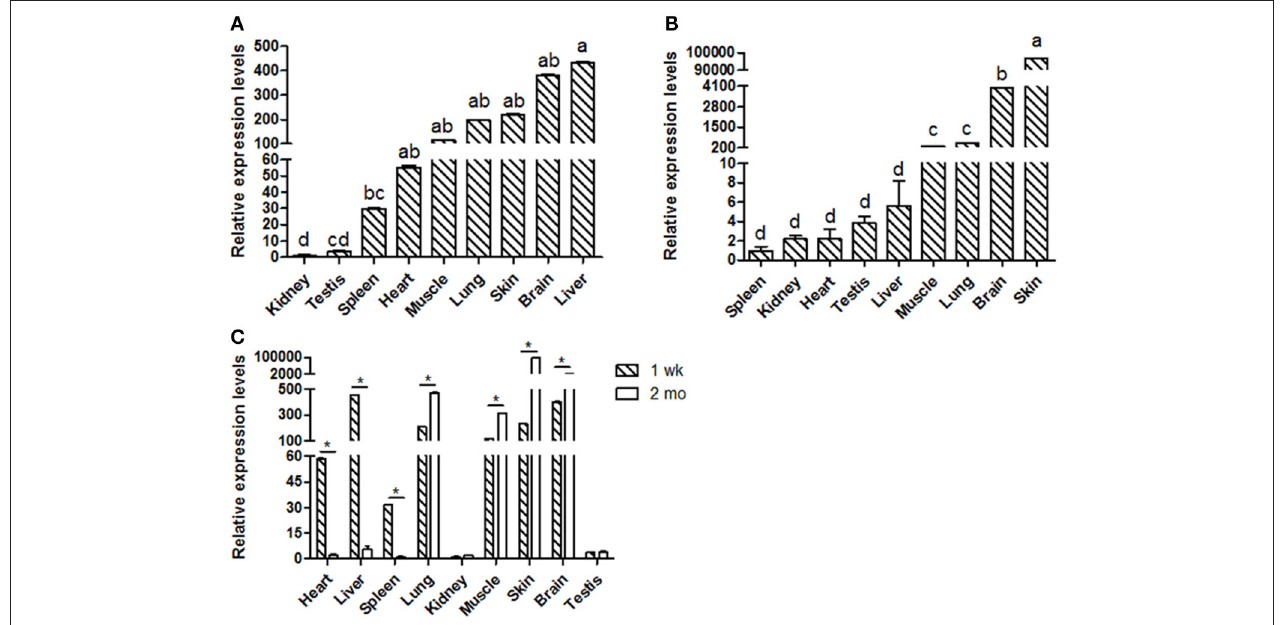
FIGURE 1 | Shaanbei white cashmere goat KDM6A mRNA expression patterns detected by qPCR. (A) Different tissues of 1 wk Shaanbei white cashmere goat; (B) Different tissues of 2 mo Shaanbei white cashmere goat. (C) The comparison of goat KDM6A tissue expression levels between 1 wk and 2 mo. Data represent means ± SE ( n = three samples of each tissues). Columns with different letters (a, b) means P < 0.05; * P <